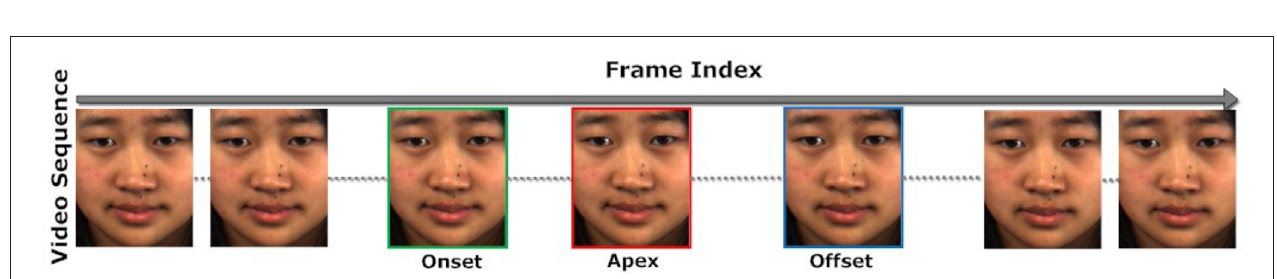
FIGURE 6 | A video sequence depicting the order in which onset, apex and offset frames occur. Sample frames are from a “Happiness” sequence (Subject 2) in CASME II. Images reproduced from the database with permission from Yan et al. (2014a).